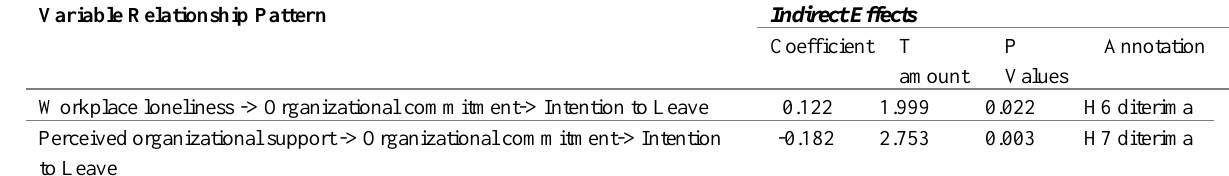
Table 7: Indirect